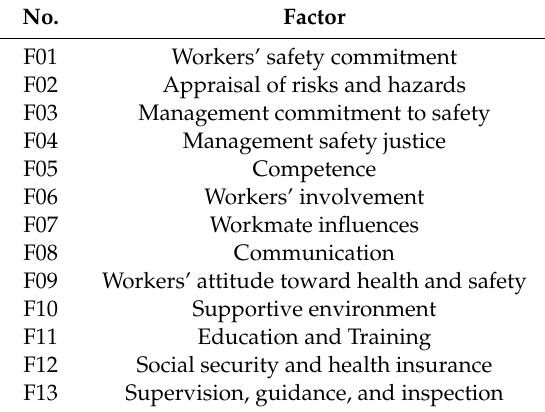
Table 1. Significant factors for safety climate evaluation (source Mosly and Makki